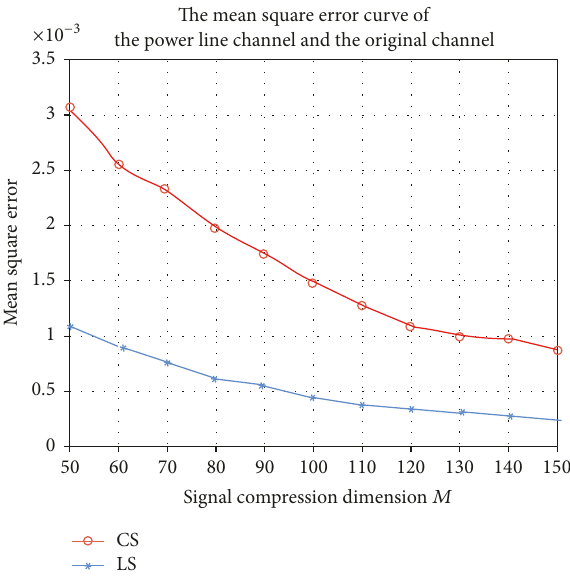
Figure 11: Performance comparison of CS and LS ( 𝑀